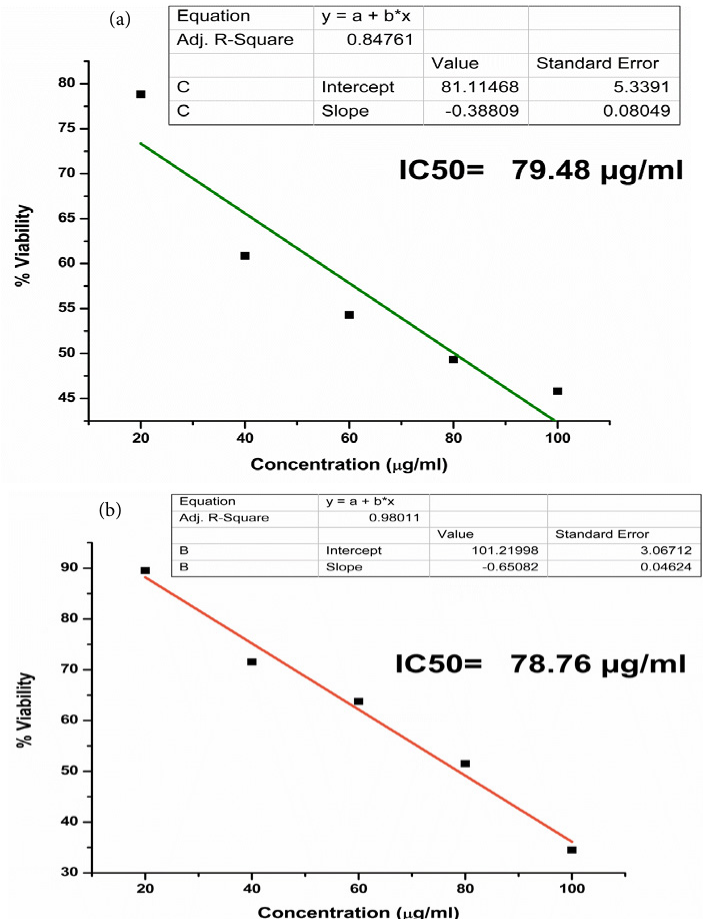
Fig. 12 Effect of concentration of BL-AgNPs on % viability, a) A549 and b) MCF7 cells